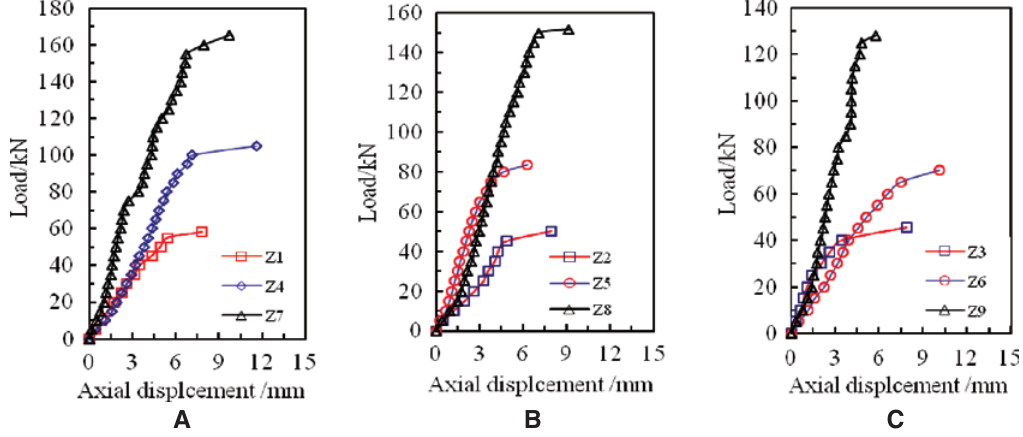
Figure 15: N-u curves for different cross-sectional